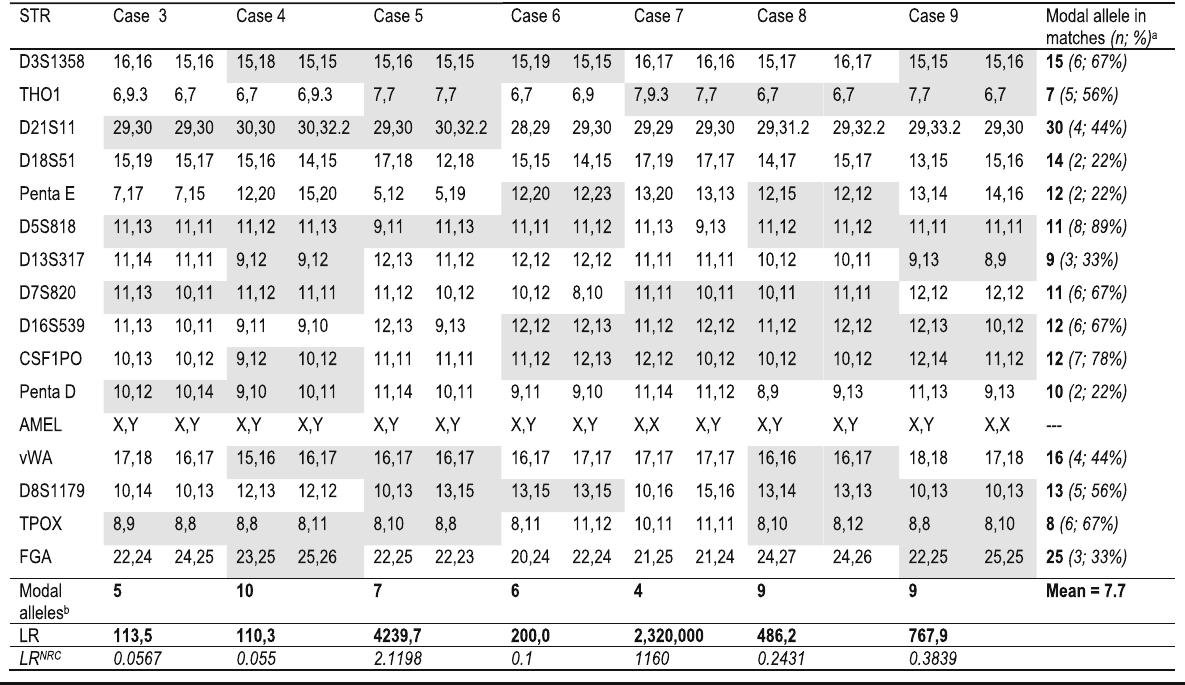
Table 2 Fortuitous matching cases found during the inclusion of DNA profiles (PowerPlex® 16 System) to the STR database of the state of